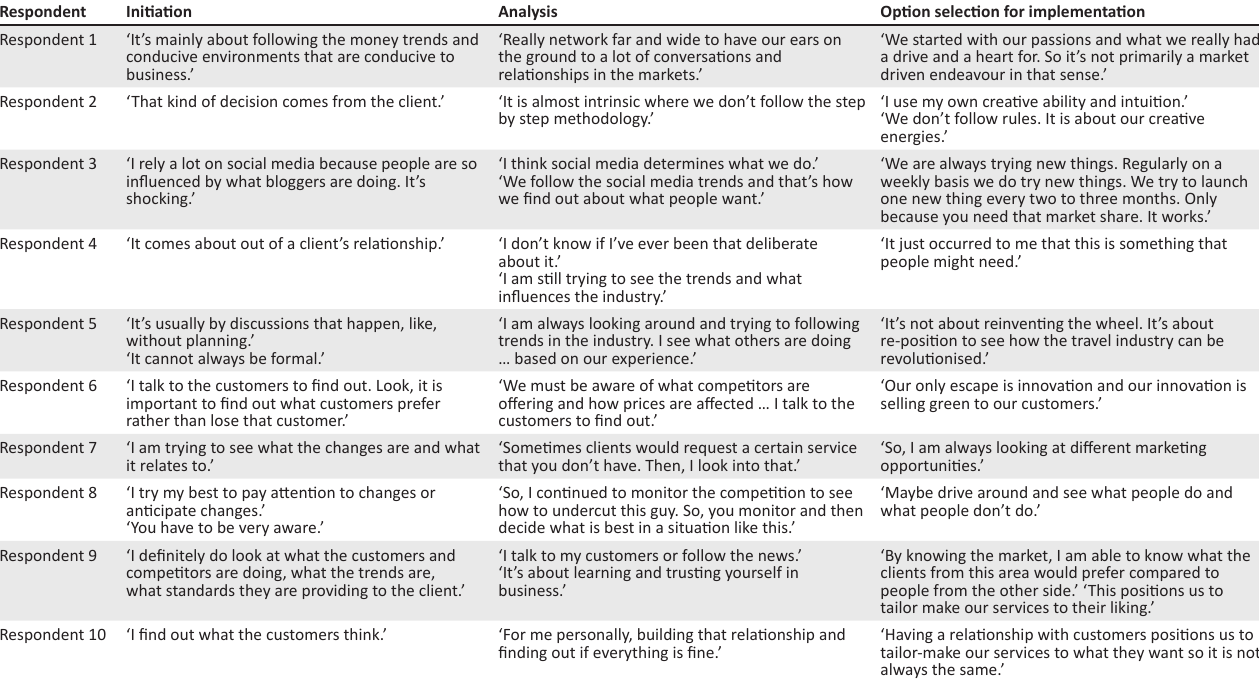
TABLE 1: Semi-structured interview samples of the strategic decision-making process.